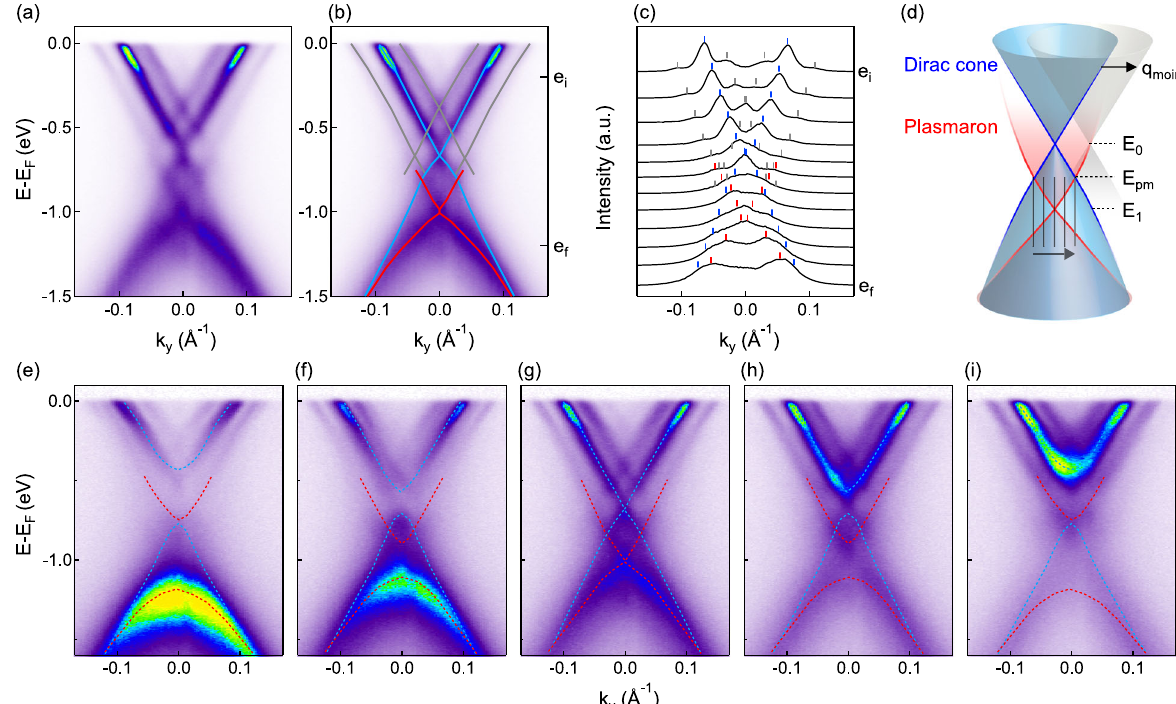
Fig. 4 Electronic structure at doping level of 5.8 × 10 13 cm − 2 to show the plasmaron dispersion. a , b Electronic structure at the highest doping (5.8 × 10 13 cm − 2 ) through the K point along the K-K direction. Dispersions extracted from MDCs are appended as blue, red and gray curves in b . c MDCs with energy range from e i to e f shown in b , and the colored marks indicate peaks and are over-plotted in b . d A schematic of electronic structure at the highest doping level. Blue, red and gray colors represent the original graphene Dirac cone, plasmaron bands and the moiré superlattice bands, respectively. e – i Cuts parallel to the K-K direction throughout the momentum range of the diamond shape (indicated by gray lines in d